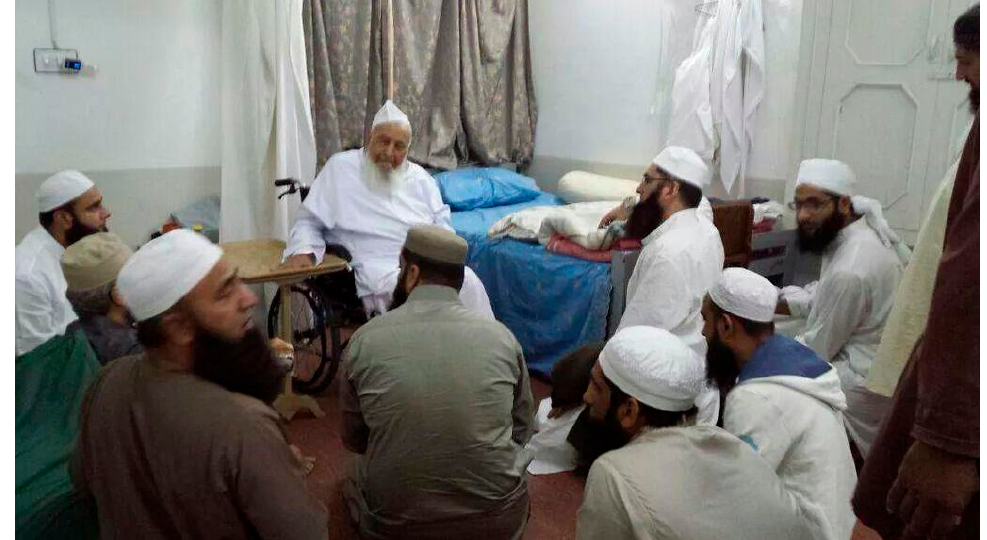
Figure 2. “With one of my favorite elders. Hafiz Patel sahib of Dewsbury UK. Raiwind ijtema 2014.